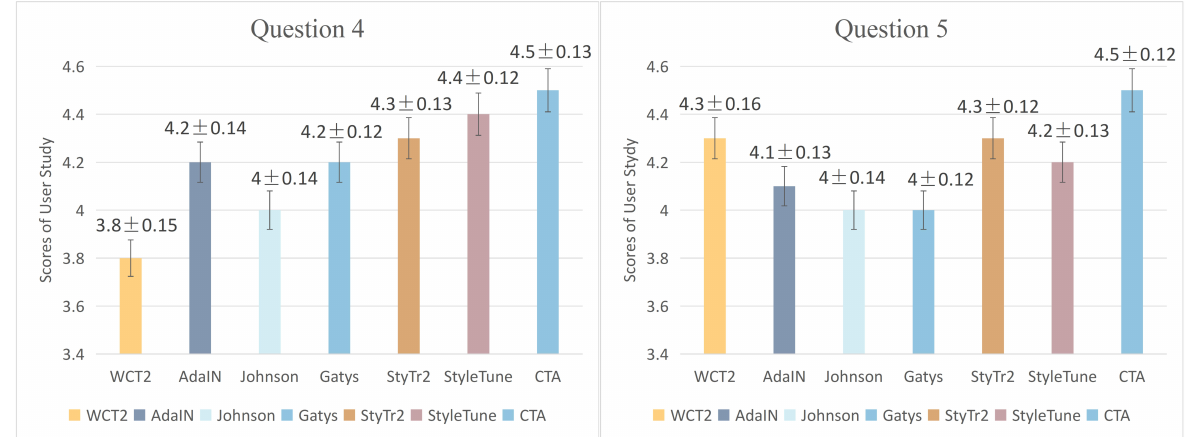
Figure 8. Questionnaire results of question 4 and